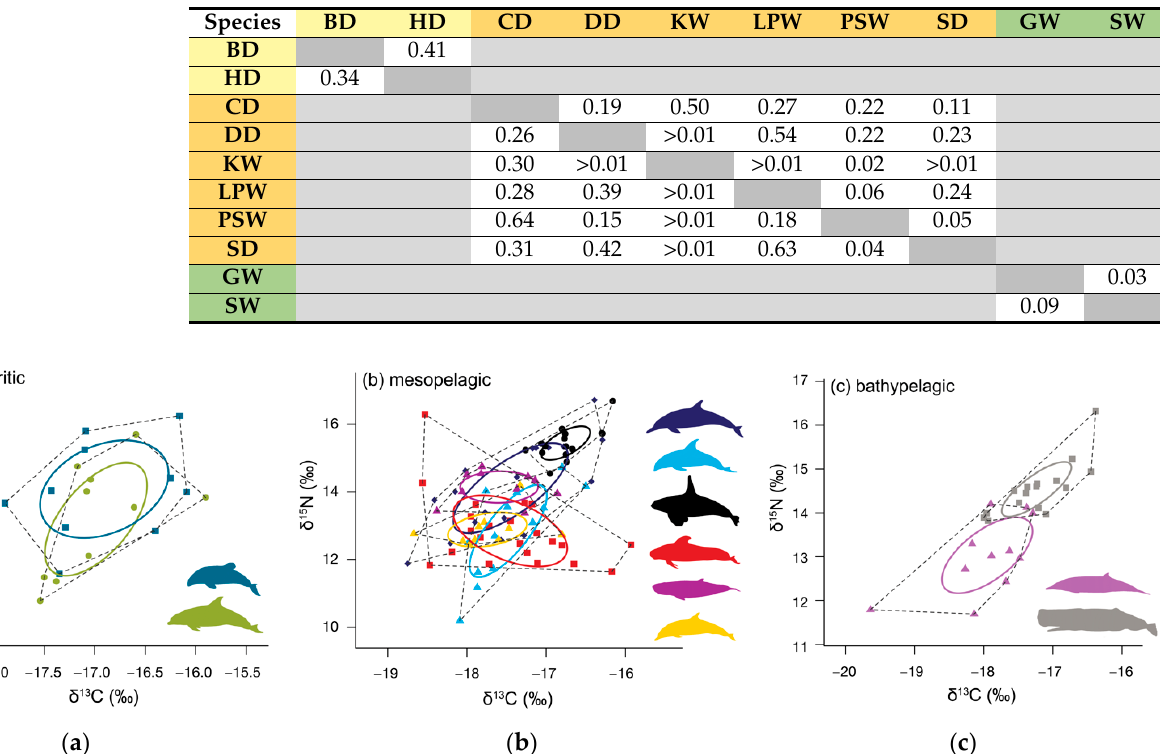
Table 4. Bayesian niche overlap (40%) for each species (left column) with each other species (top row) in their habitat group for species with n ≥ 10. Species abbreviations: Neritic group (yellow): BD = bottlenose dolphin, HD = Hector’s dolphin, mesopelagic group (orange): CD = common dol- phin, DD = dusky dolphin, KW = killer whale, LPW = long-finned pilot whale, PSW = pygmy sperm whale, SD = striped dolphin, bathypelagic group (green): GW = Gray’s beaked whale, SW = sperm whale. Dark grey indicates matrix diagonal, light grey fields refer to species not in the same habitat. Species BD